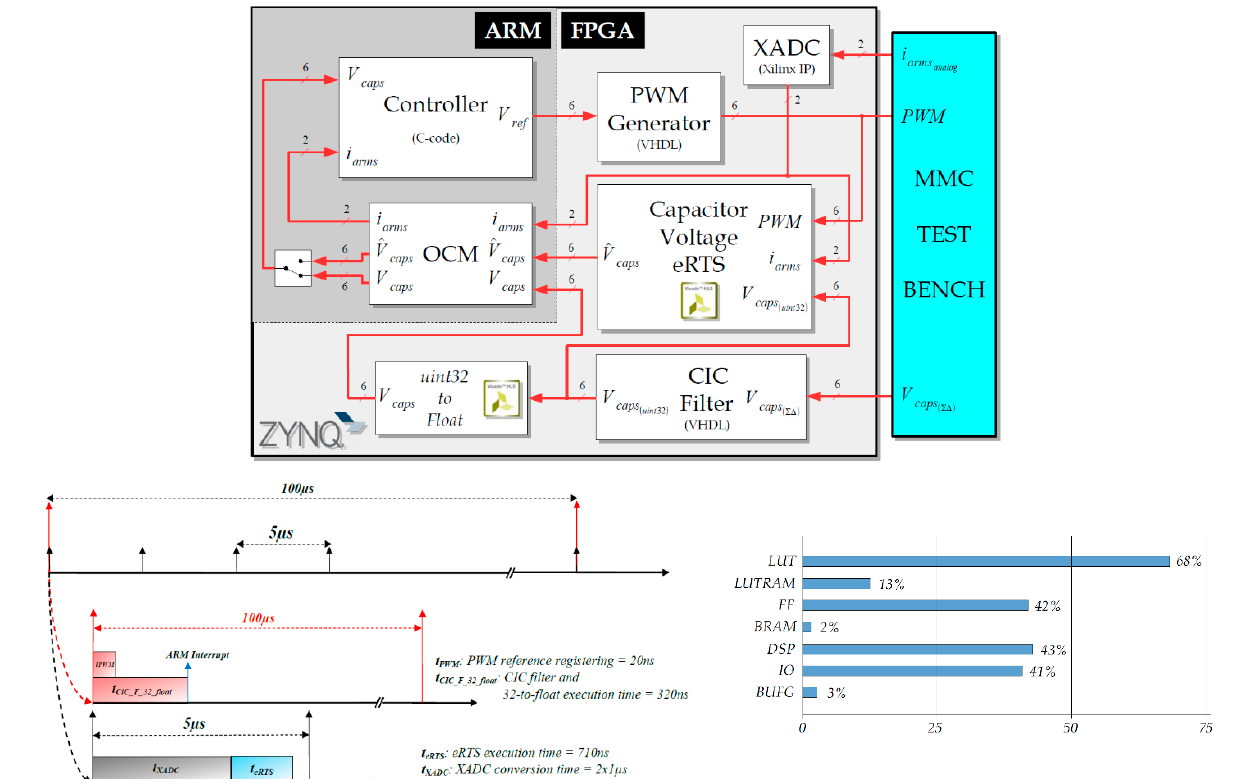
Figure 6. Overview of the global sensorless control architecture, timing diagram and resource consumption of the overall design.